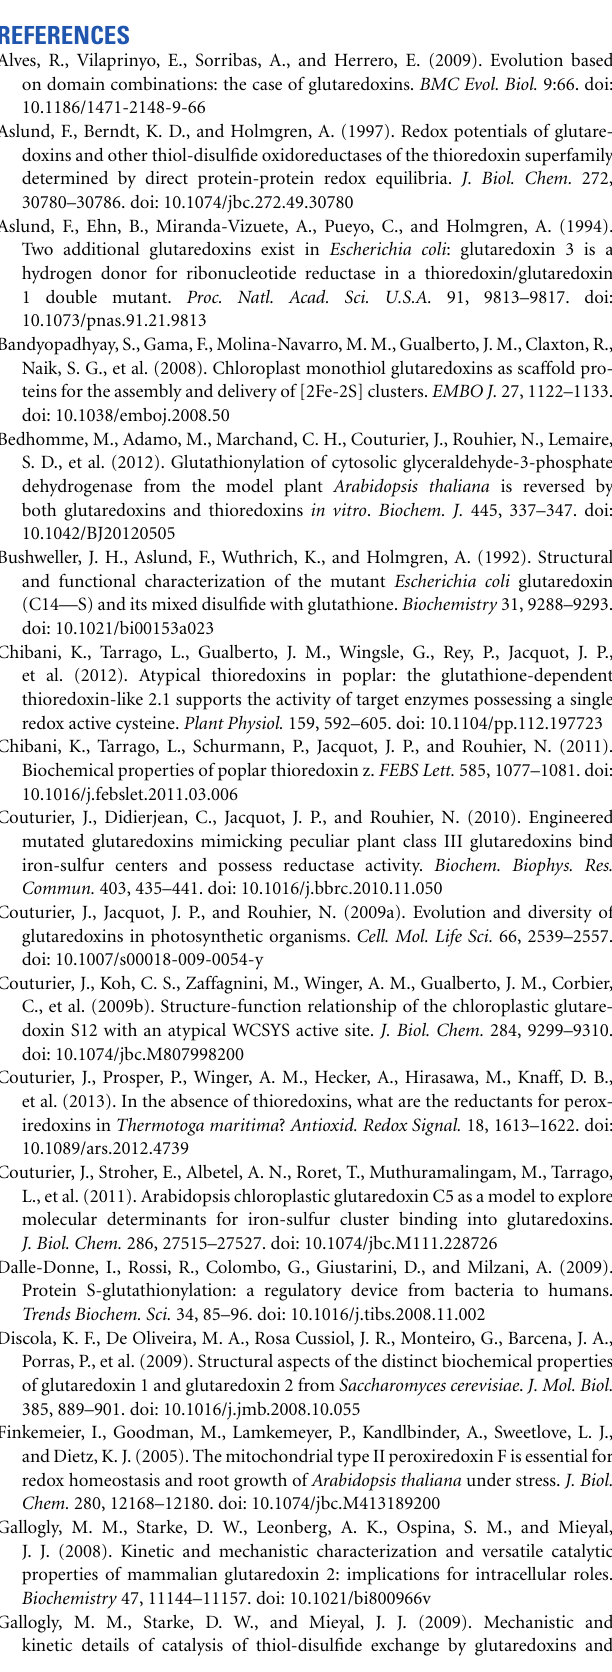
Figure S6 | Electrospray ionization mass spectrometry analysis of PtGrxC2 C80S. Spectra of whole protein were determined for reduced protein before (A) and after treatment with GSSG (B), GSNO (C), or H 2 O 2 (D) as described in the Methods